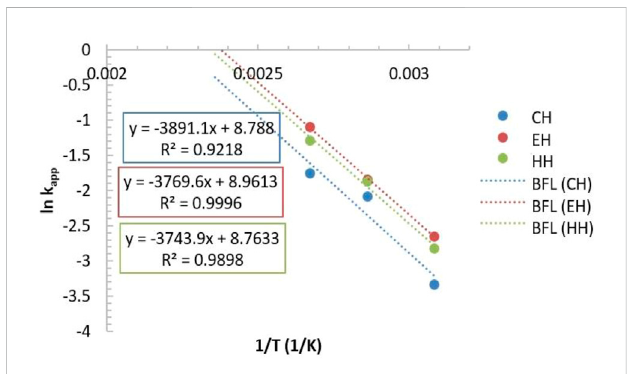
FIGURE 4 The relationship between lnKapp versus the reciprocal of absolute temperature. Condition [CL]: [FeCl 3 ] =